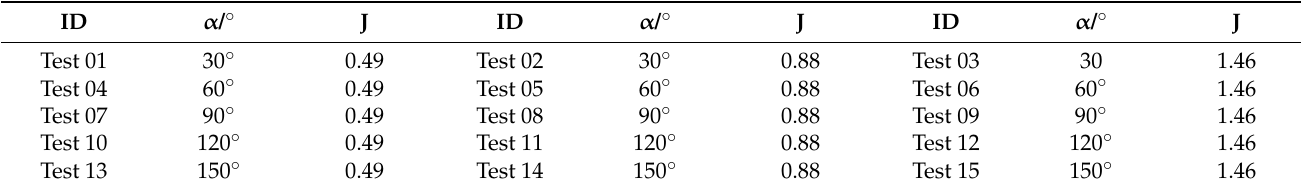
Table 3. Identification and conditions of the 15 tests carried out during the experiments.